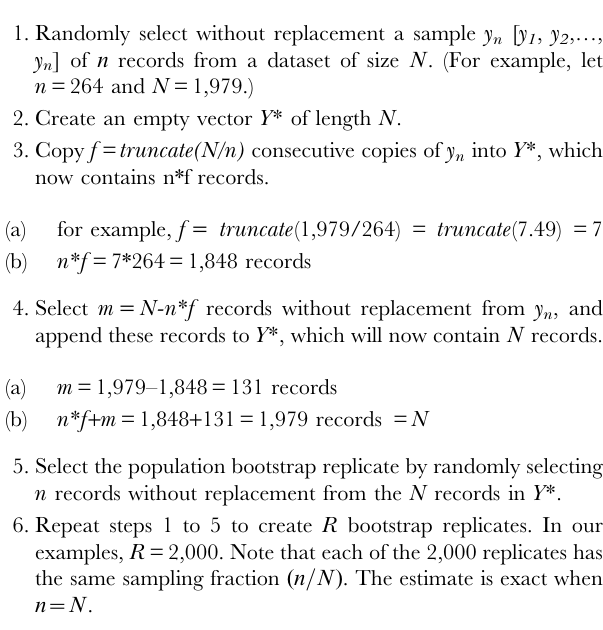
Figure 2 and Table 4 summarize the simulations executed, and the datasets used.